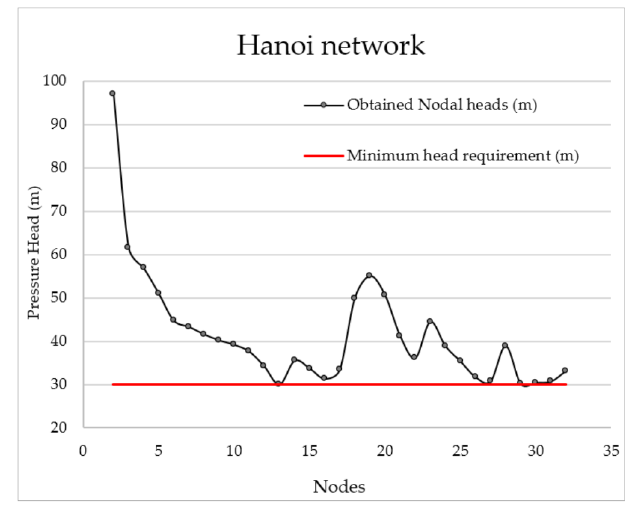
Figure 11. The Hanoi network nodal pressure heads.